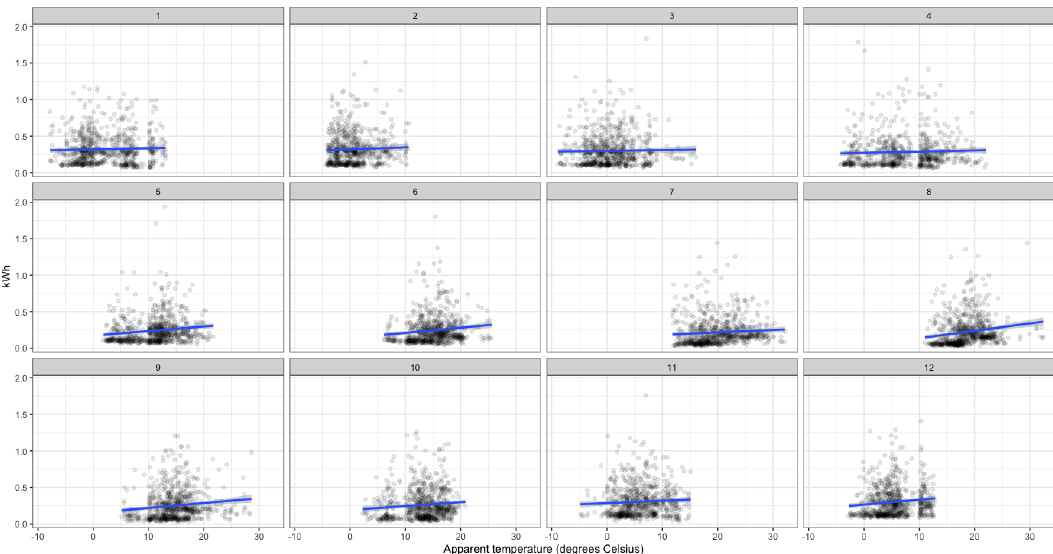
Figure 8. Consumption for smart-meter 18 vs temperature per month of 2013.